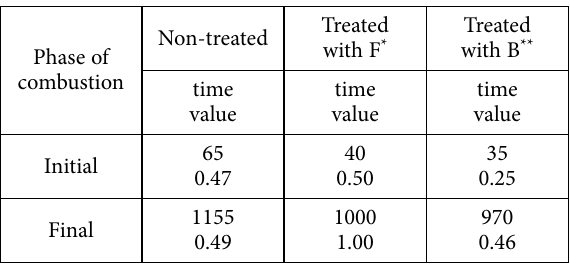
Treated with B ** time value 35 0.25 970 0.46